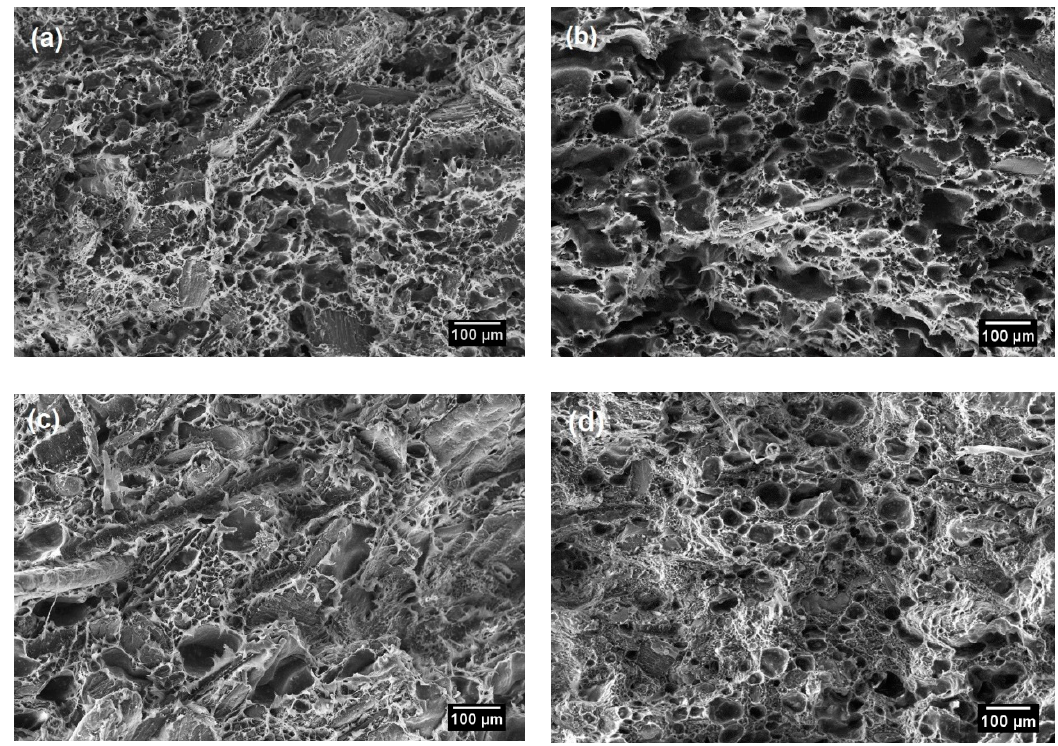
Figure 6. SEM morphology of ( a ) untreated, ( b ) UV / O 3 -, ( c ) alkali- and ( d ) acid-treated RH / rHDPE composite foam of 50 wt.% rice husk filler.